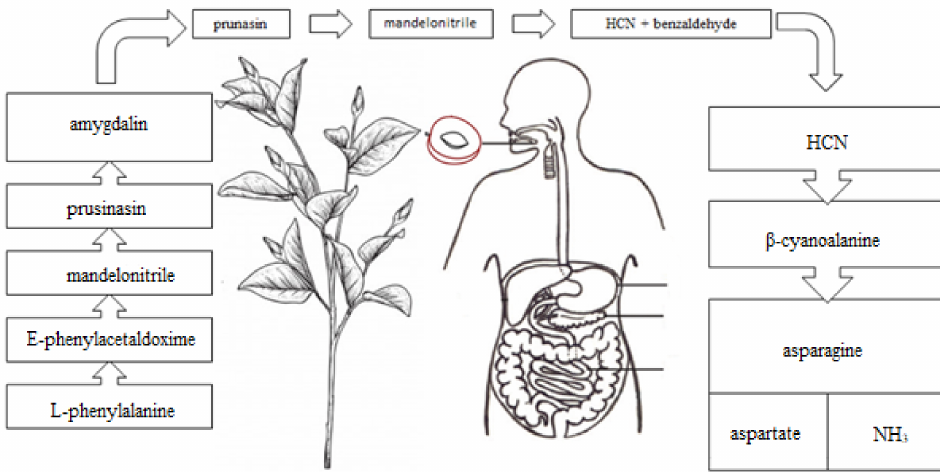
Figure 4. Hydrogen cyanide formation as a result of hydrolysis of